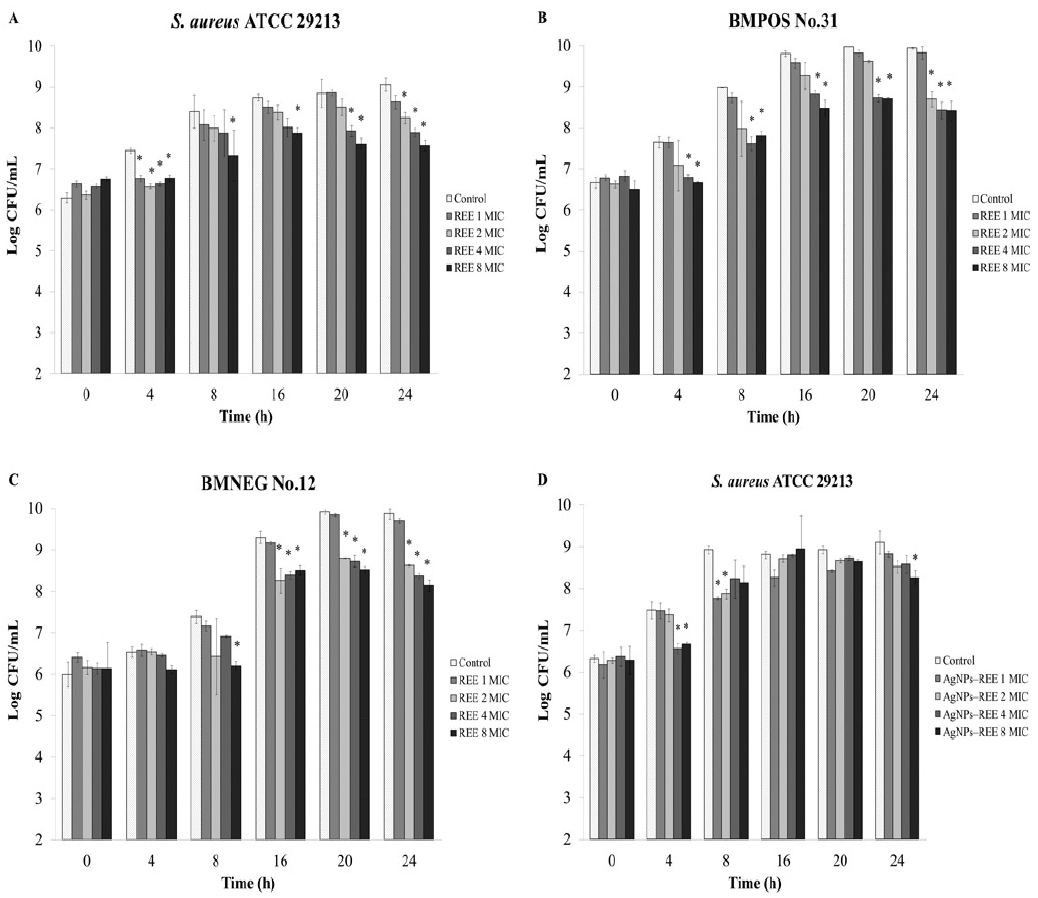
Figure 4. Figure 4. Cont.